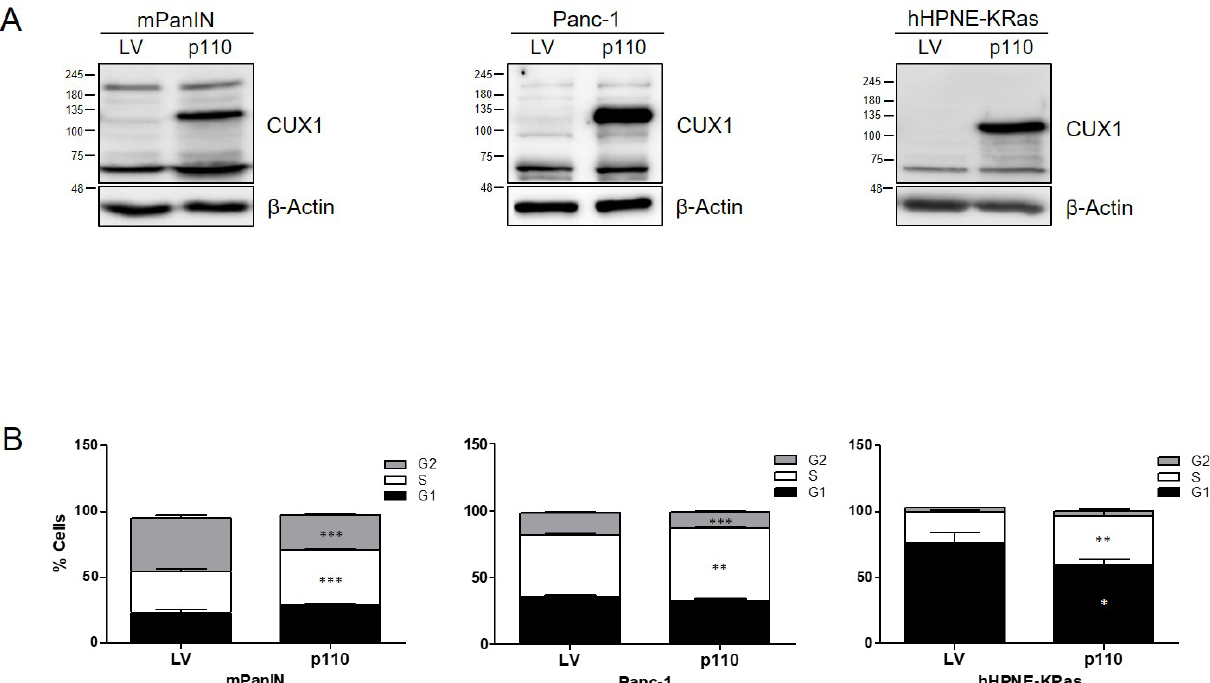
Figure 5. p110 CUX1 enhances cell cycle progression in KRAS-mutant pancreatic cell lines. ( A ) Analysis of p110 CUX1 protein levels in whole cell lysates of stably transduced mPanIN, Panc-1 and hHPNE-KRAS cells. Actin served as control. ( B ) Cell cycle analysis by flow cytometry showing increased S-phase progression in p110 CUX1 overexpressing mPanIN and hHPNE-KRAS cells compared to empty vector cells (LV). Graphs represent the mean percentage ± SD of cells in G1 (black), S (white) and G2 (grey) phase and are representative of three independent experiments. *** p ≤ 0.0009; ** p ≤ 0.0014–0.009; * p ≤ 0.03. The uncropped Western Blot images can be found in Figure S9 and the densitometry analysis can be found in Figure S10.